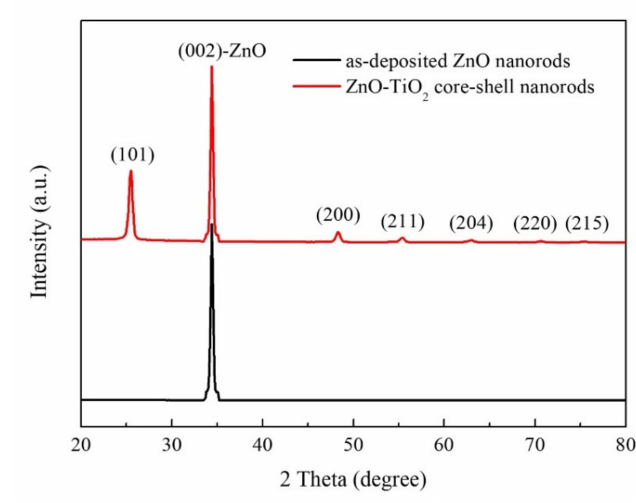
Figure 4. GIXRD patterns of as-deposited ZnO nanorods and ZnO–TiO 2 core–shell nanorods.